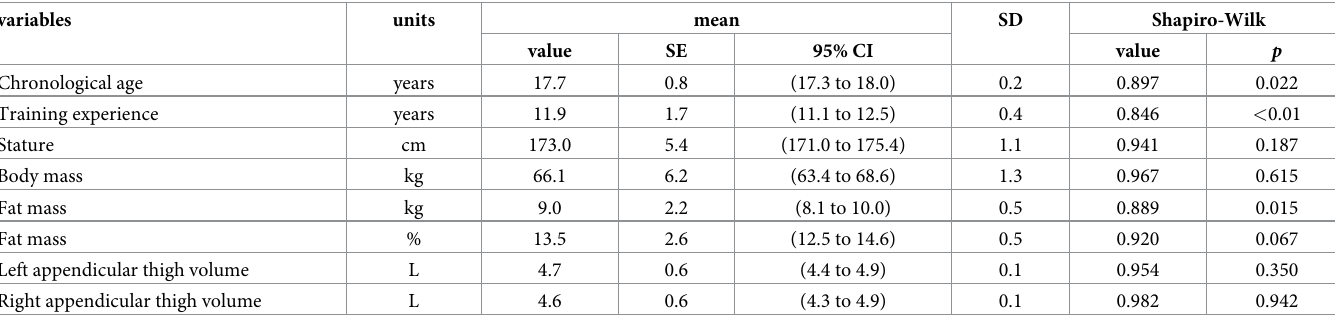
Table 1. Descriptive statistics and normality test for the total sample considering crhonovariables and anthropometry (n = 23).